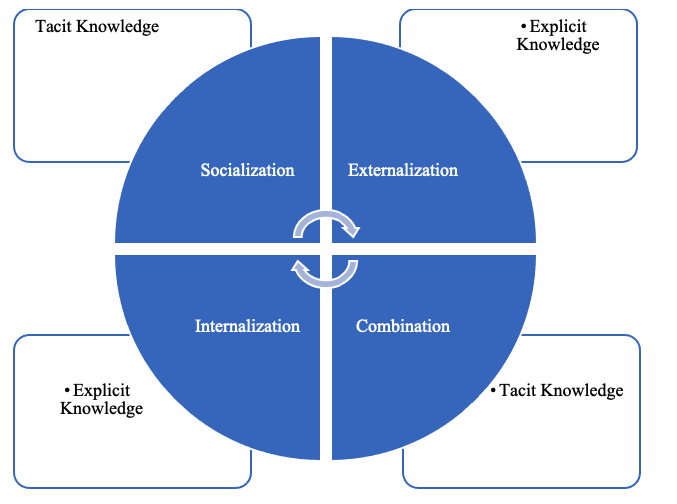
Figure 1: Knowledge Conversation; Source: Nonaka, I. and Takeuchi, H. (1995). The Knowledge-Creating Company: How Japanese Companies Create The Dynamics of Innovation. New York: Oxford University